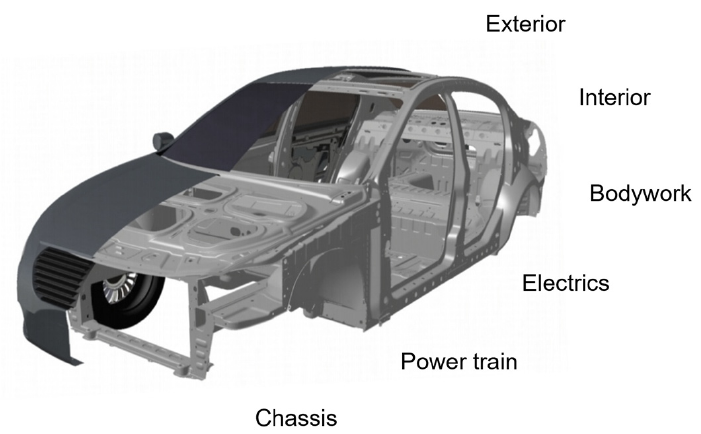
Figure 8. Main modules of a car.